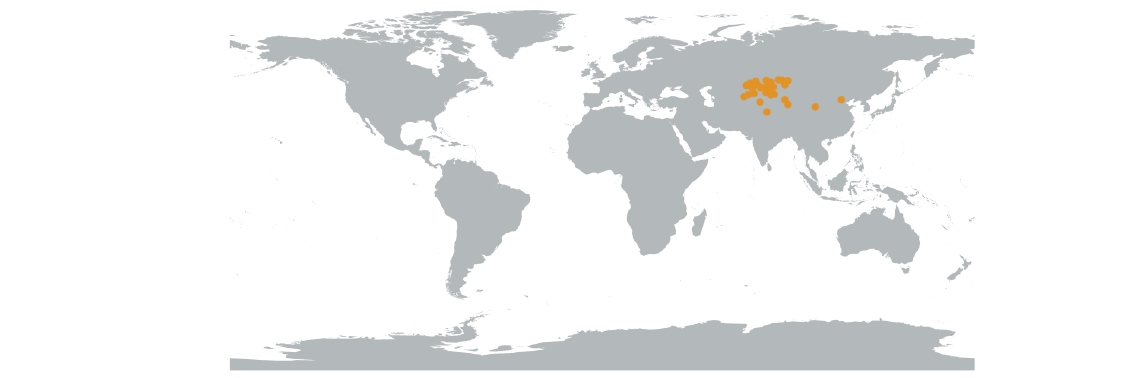
Fig. 13. Distribution of Malus sieversii (Ledeb.)